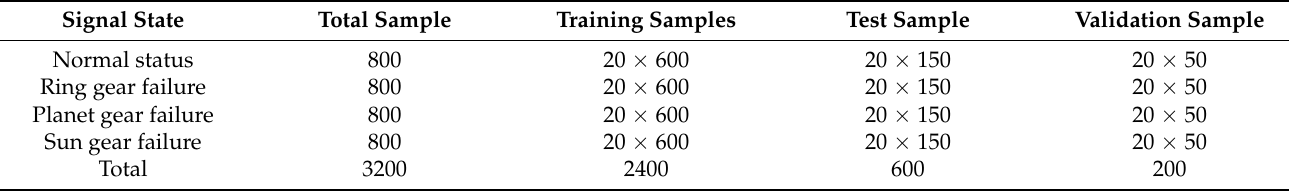
Table 3. Four preset fault characteristic parameter